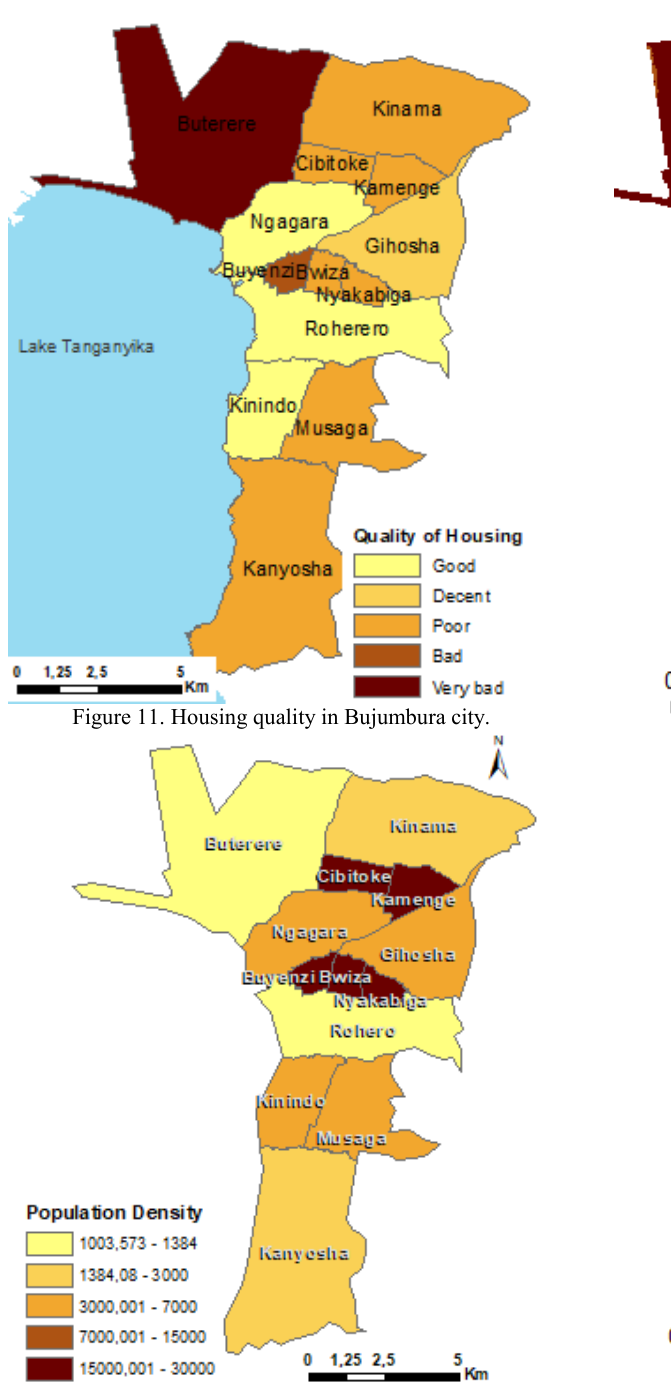
Figure 12. Population density by municipalities.